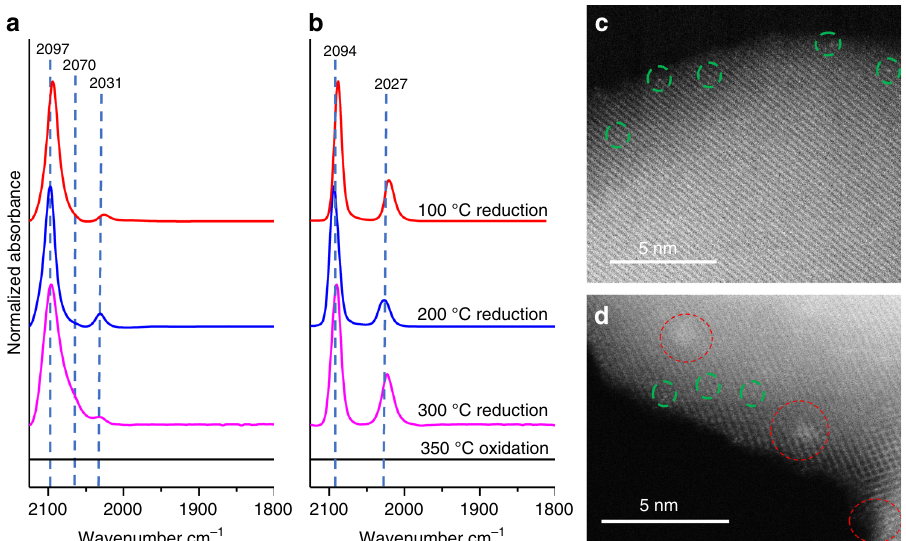
Fig. 5 Rh SAC on TiO 2 following varying environmental treatments. IR spectra of CO adsorbed at full saturation coverage following varied pretreatment conditions (oxidized at 350 °C (black), reduced at 100 °C (red), 200 °C (blue) and 300 °C (pink)) measured at a − 120 °C and b 20 °C. Corresponding representative high-angle annular dark- fi eld (HAADF) STEM images of c 100 °C H 2 reduction case in which single Rh atoms are observed and d 300 °C H 2 reduction case in which small Rh clusters and Rh single atoms are observed. Green circles identify the single Rh atoms, while red circles identify Rh